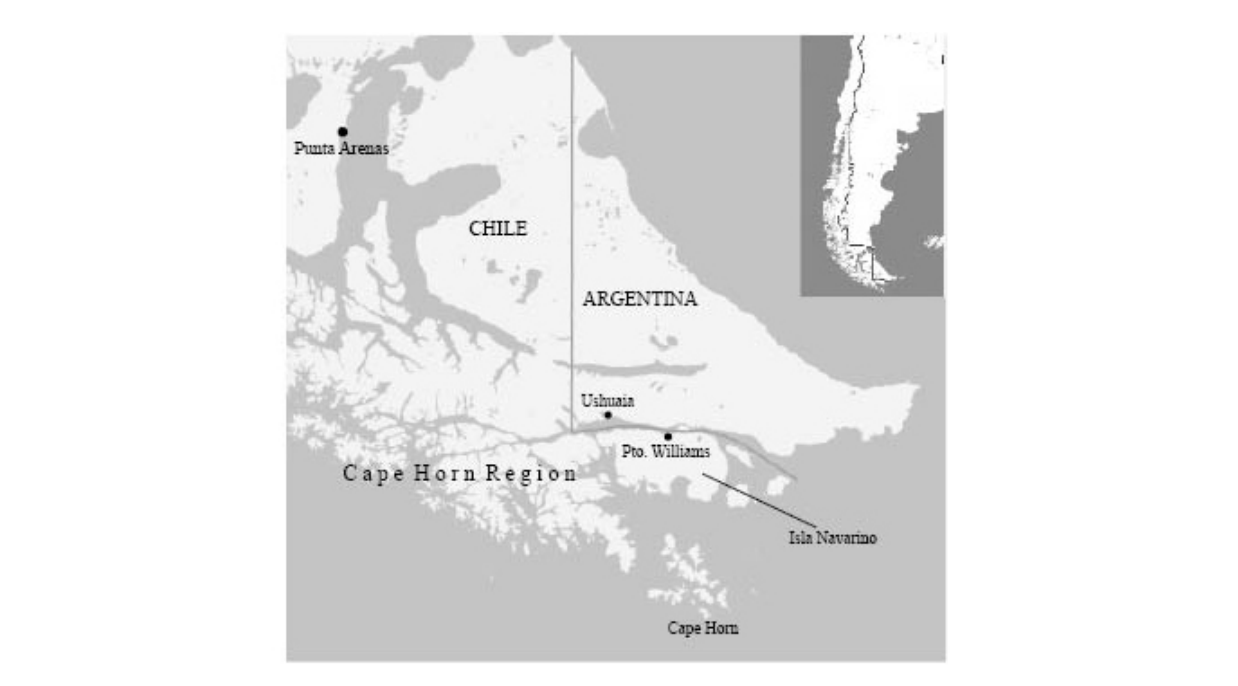
Fig. 1 . The Cape Horn